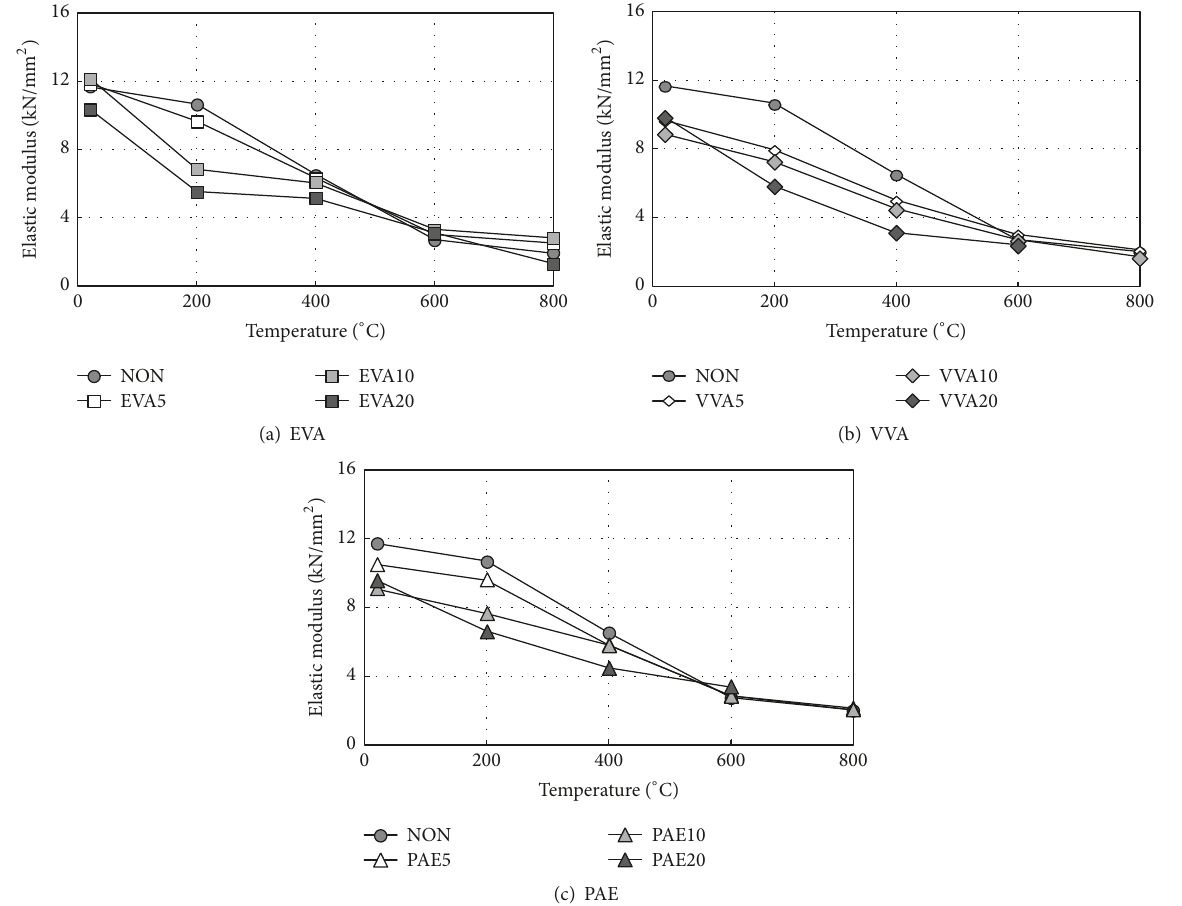
Figure 14: Modulus of elasticity of PCM with various polymers at high